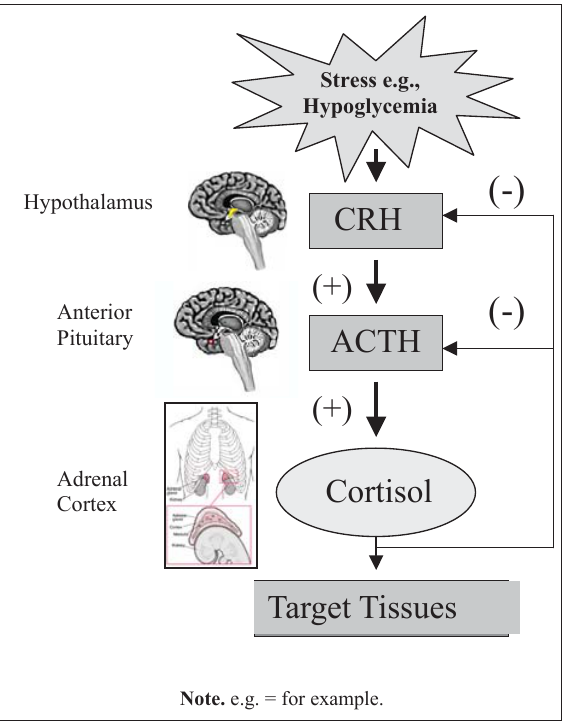
Figure 1. Hypothalamic-pituitary-adrenal (HPA) axis responsible for regulating the levels of cortisol in the